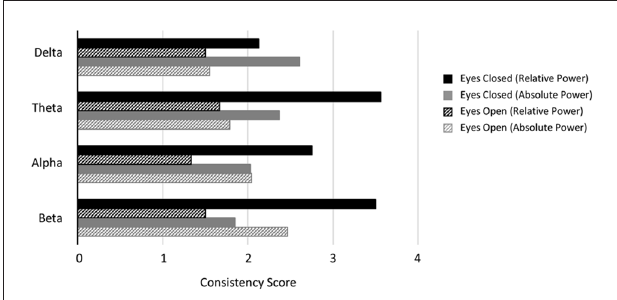
FIGURE 4 | Consistency scores aggregated across disorders for each band and condition. Consistency scores (frequency of dominant result relative to other results) were between 2 and 3 for absolute power in the eyes closed condition for all bands (gray bars), between 2 and 4 for relative power eyes closed (black bars) and typically between 1 and 2 for eyes open (absolute and relative, gray and black hashed bars, except beta eyes open absolute